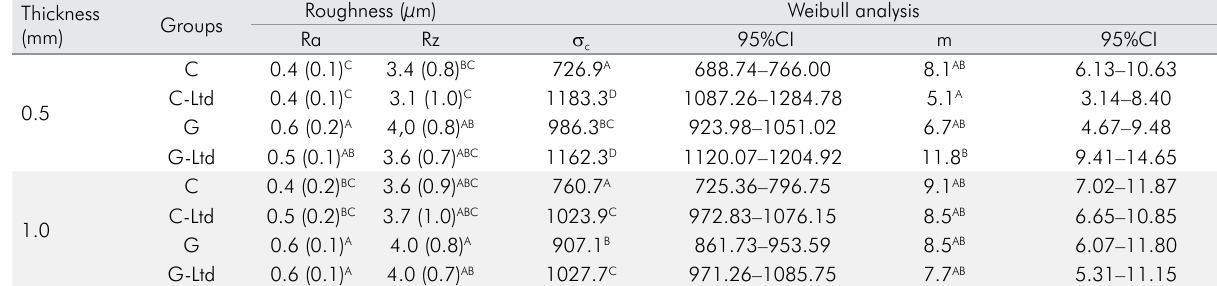
Table 2. Analysis of variance (two-way ANOVA) of roughness data (Ra and Rz), characteristic strength ( σ and respective confidence intervals (95%CI) for treatment and aging factors.